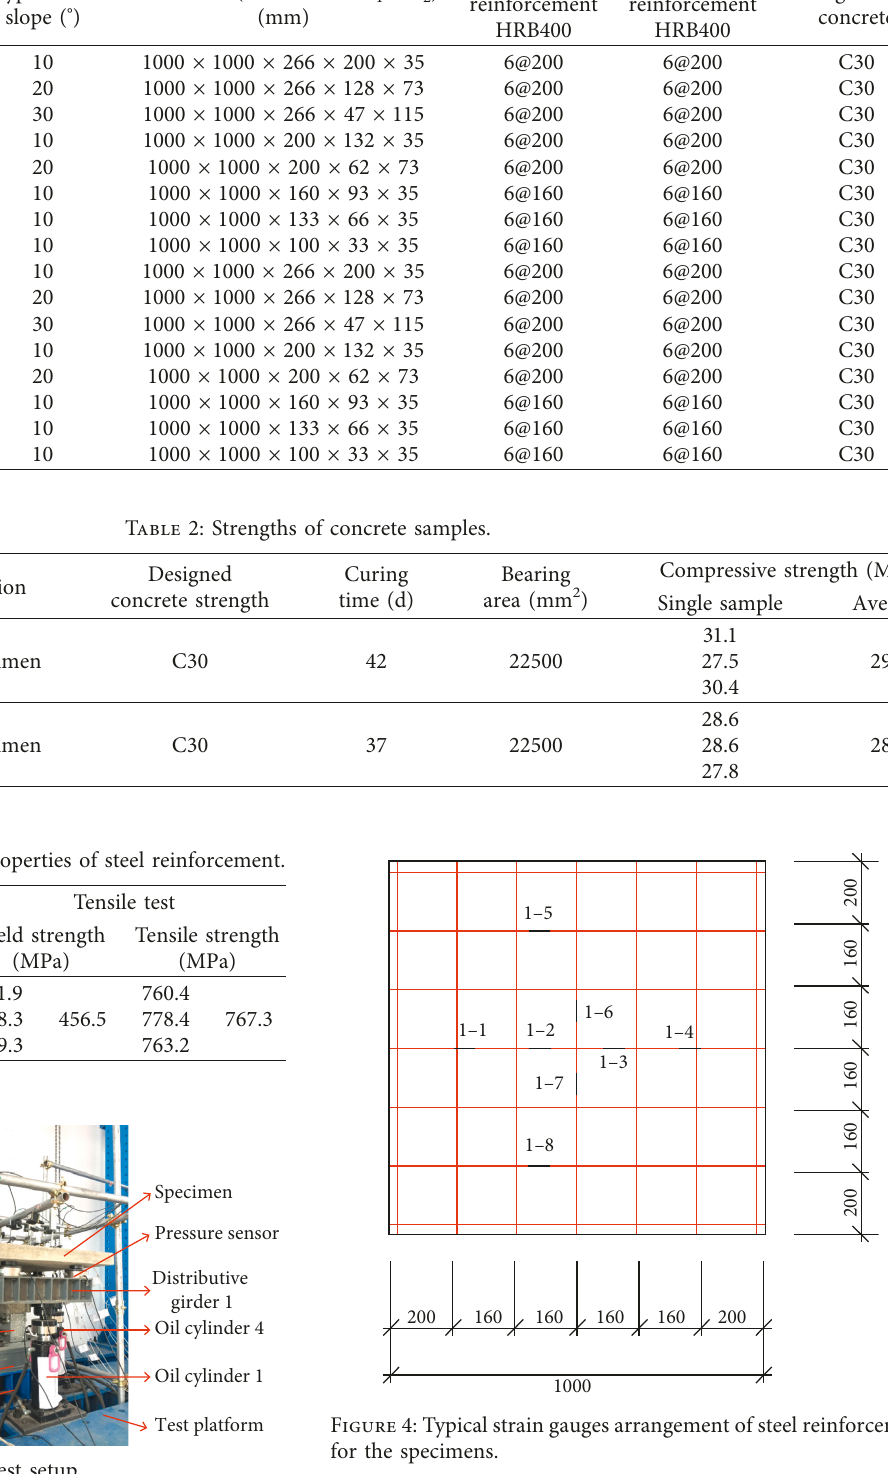
Figure 3: Test setup.